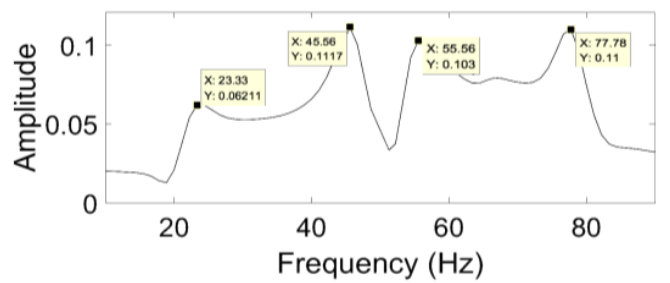
Figure 31. SCR = 1.42 in PI control system.